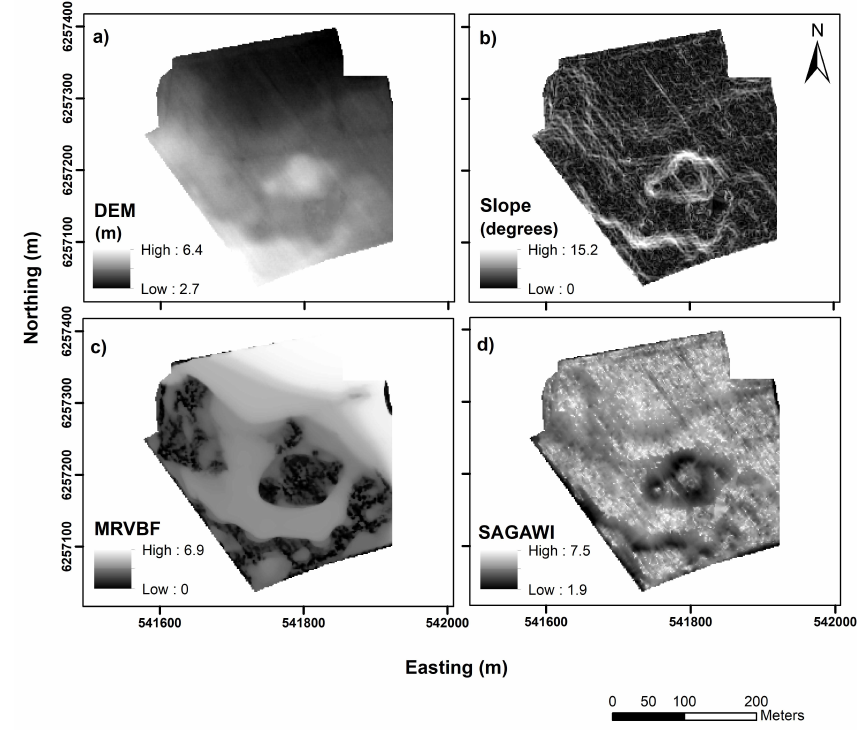
Figure 3. Examples of environmental covariates tested for the prediction of peat thickness: ( a ) Digital Elevation Model (DEM), ( b ) slope gradient, ( c ) Multi-Resolution Index of Valley Bottom Flatness (MRVBF), and ( d ) System of Automated Geoscientific Analyses Wetness Index